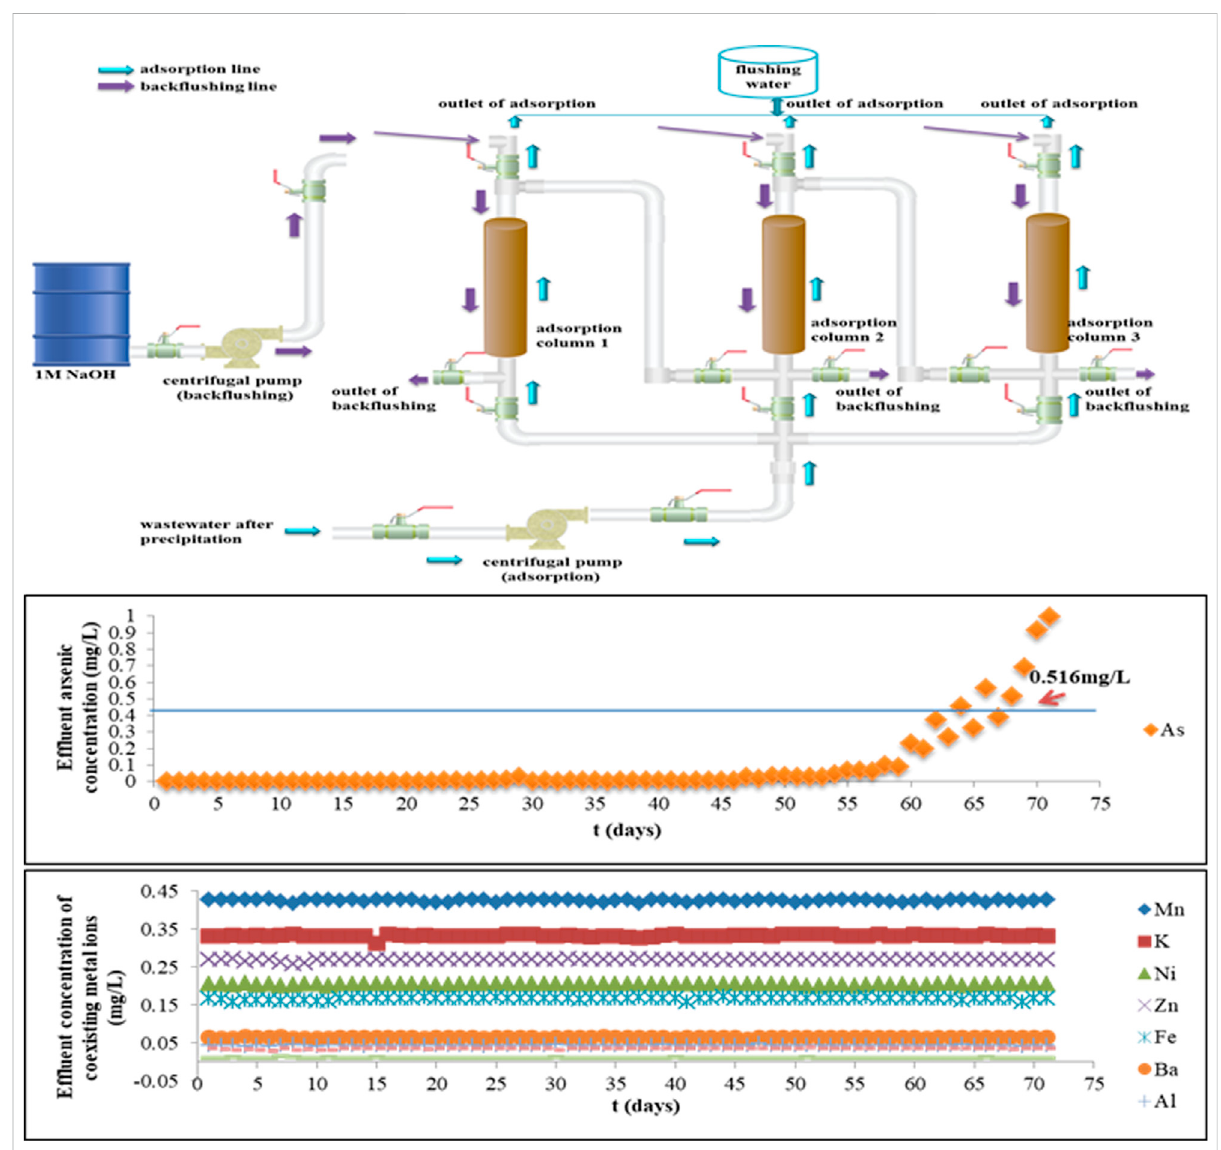
FIGURE 5 Pilot-scale schematic diagram and the performance evaluation of the adsorption and back fl ushing system for arsenic removal by